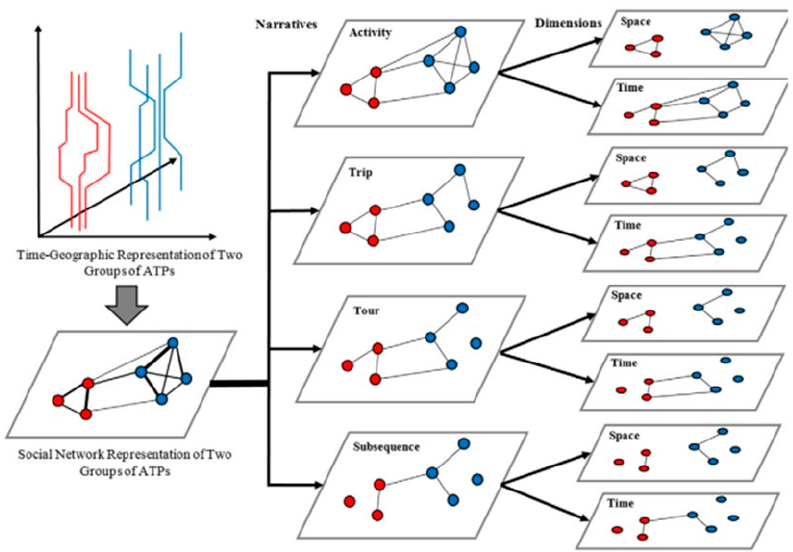
Figure 1. Conversion of Time Geography Path into Space-Time Behavior Network (Adapted from Zhang and Thill